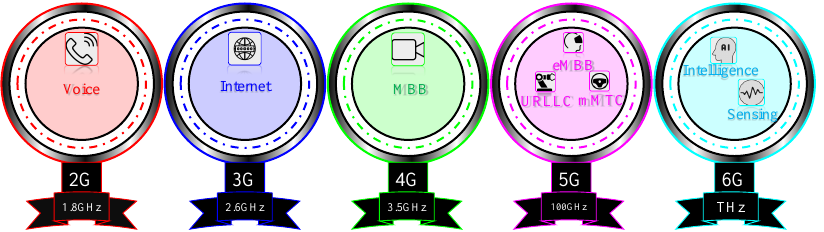
Figure 1. Evolution of mobile network from 2G to